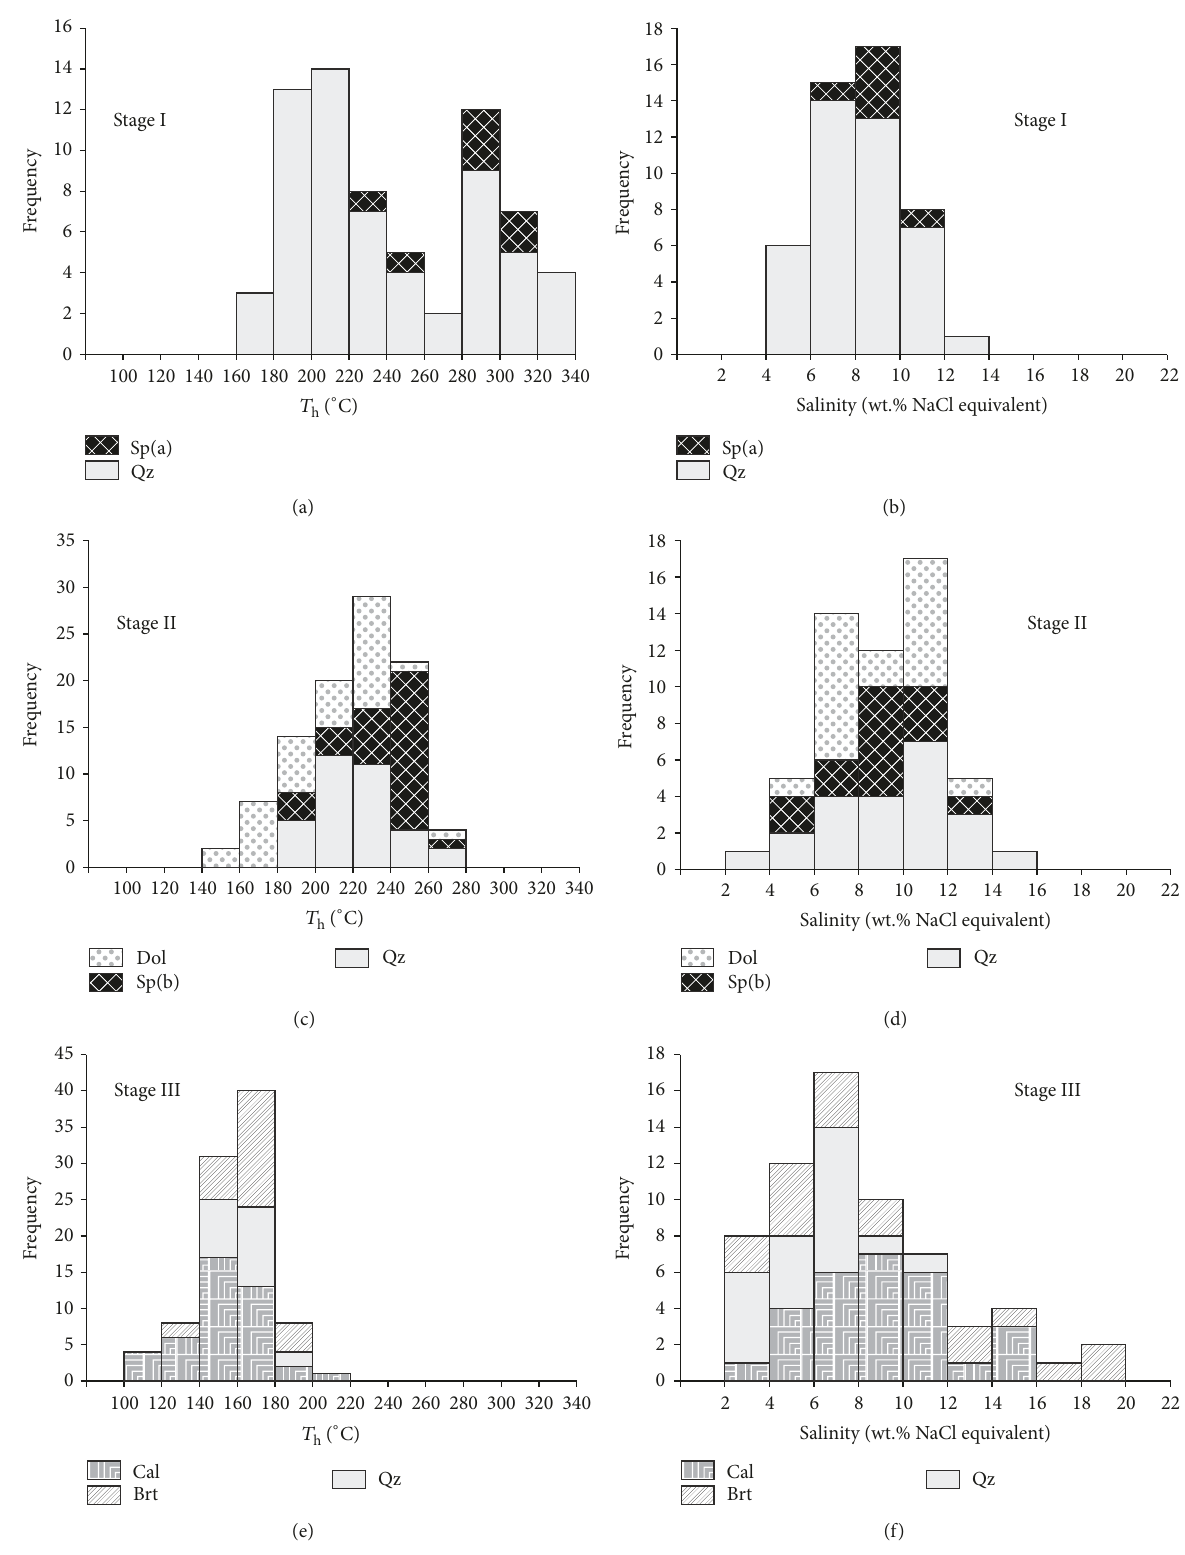
Figure 10: Histograms of total homogenization temperatures ( 𝑇 h ) and salinities at different hydrothermal stages in the Nanmushu Zn- Pb deposit. Brt, barite; Cal, calcite; Dol, dolomite; Qz, quartz; Sp(a), fine-grained sphalerite of hydrothermal stage I; Sp(b), coarse-grained sphalerite of hydrothermal stage